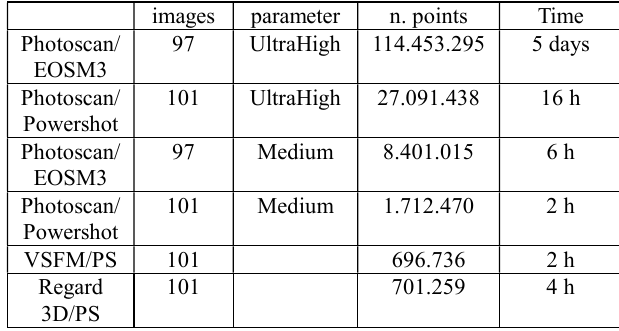
Table 2: Surveys data.